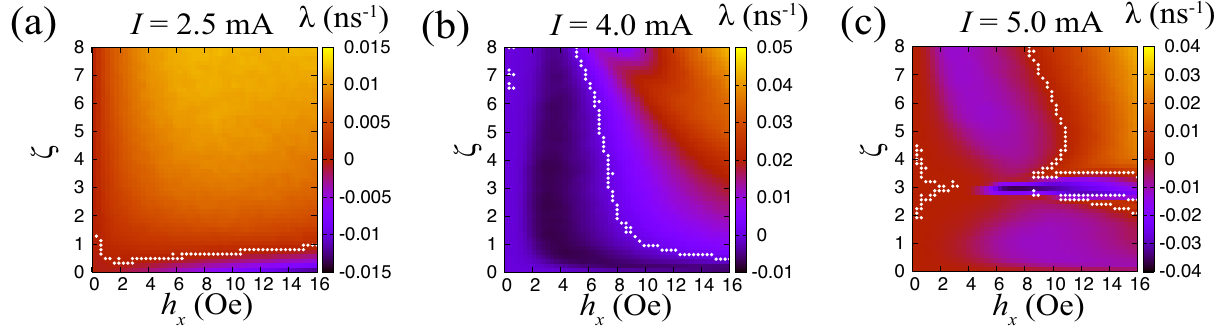
Figure 3. Dependence of Lyapunov exponent ( (cid:31) ) on the strength of the input signal ( h x ) and amplitude– frequency coupling parameter ( ζ ) for currents of ( a ) I = 2.5 mA, ( b ) I = 4.0 mA, and ( c ) I = 5.0 mA. The pulse width is 3.0 ns. The white dots represent the zero-exponent